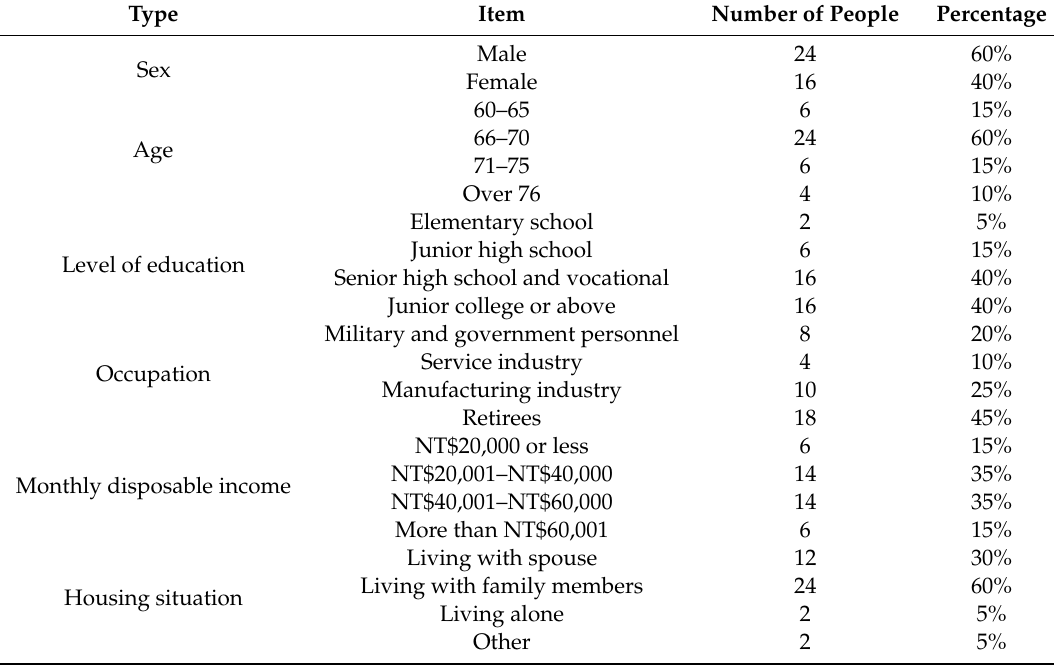
Table 1. Description of the interview